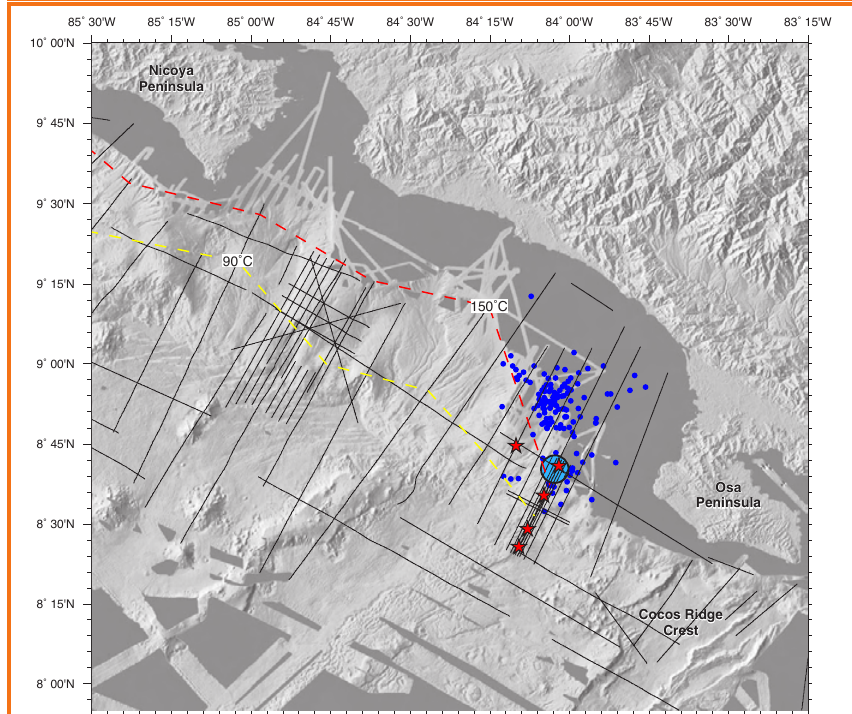
Figure 1. [B] Long-term subsidence history of the Costa Rica margin composed with data from several drill sites offshore the Nicoya Peninsula. Paleodepth information was obtained from studies of benthic foraminifera in the slope sediment, indicating a non-linear subsidence (two main pulses) of about 4 km for the middle continental slope (Vannucchi et al.,